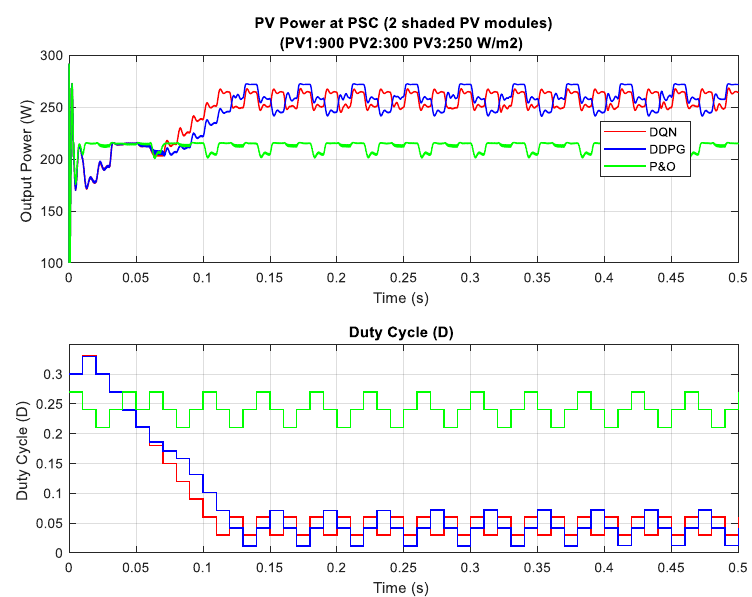
Figure 17. P – V curves of a PV array under uniform and partial shading conditions.